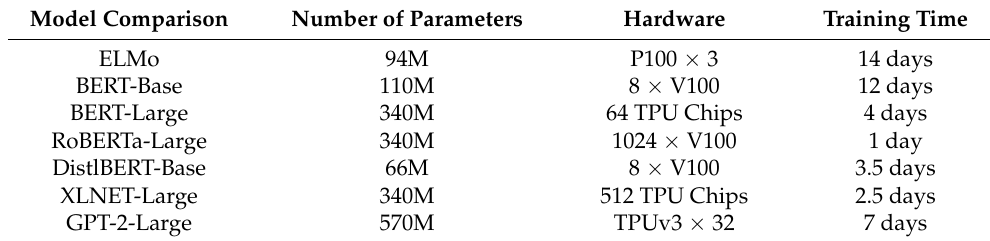
Table 4. Training parameters vs Training